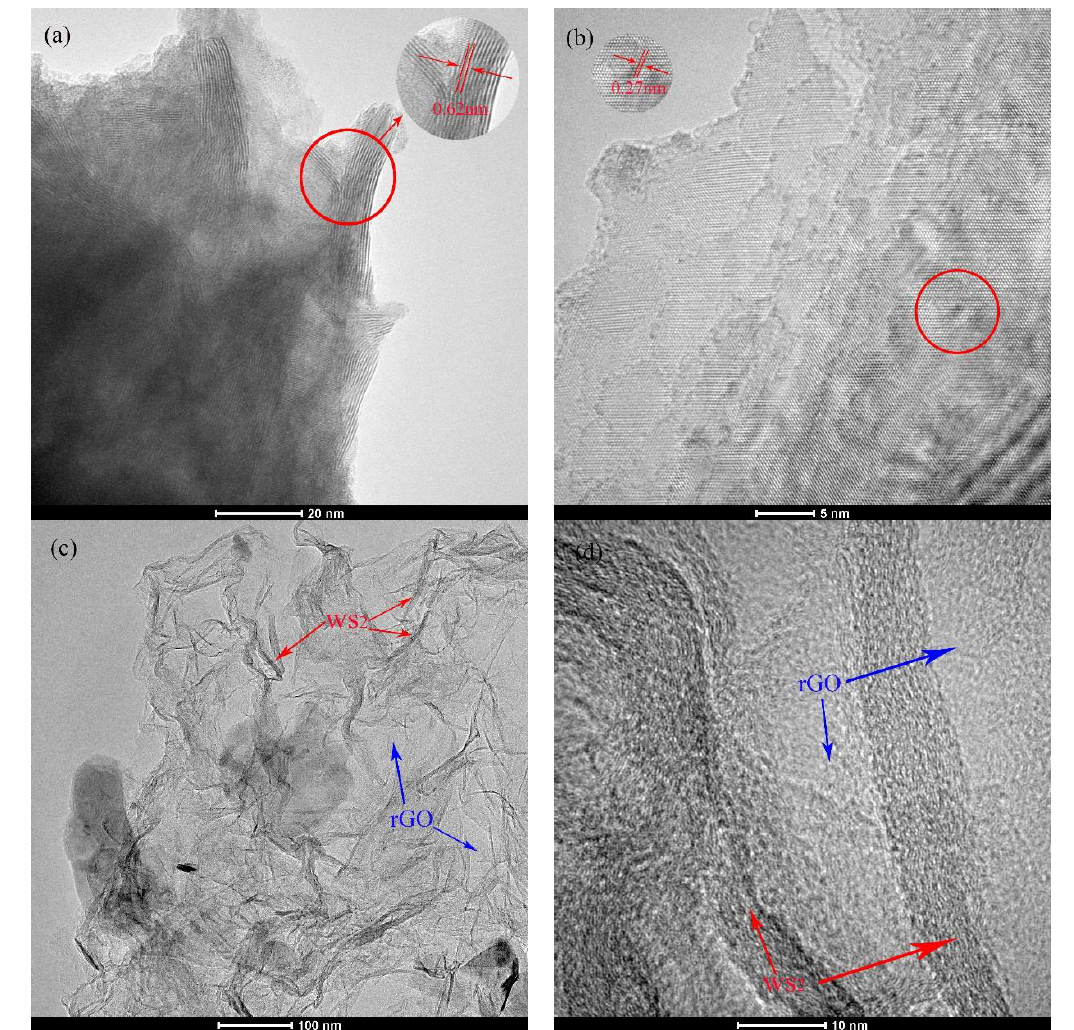
Figure 4. TEM and HRTEM images of ( a , b ) bulk WS 2 ; ( c , d ) WS 2 /rGO.